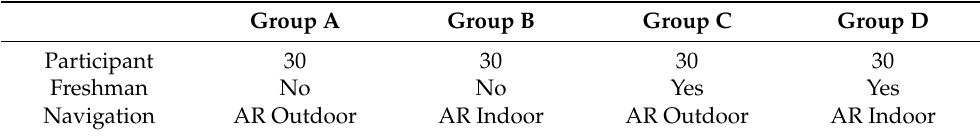
Table 1. The differences between Group A, B, C and